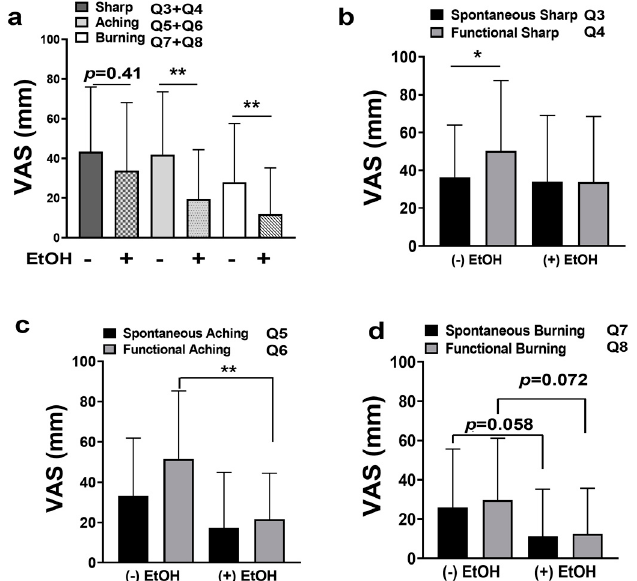
Figure 4. ( a ) VAS scores for total sharp pain (Q3 and Q4 combined), total aching pain (Q5 and Q6 combined), and for total burning pain (Q7 and Q8 combined) (+/ − ) EtOH consumption. ( b ) VAS scores for spontaneous sharp pain (Q3) vs. functional sharp pain (Q4) (+/ − ) EtOH consumption. ( c ) VAS scores for spontaneous aching pain (Q5) vs. functional aching pain (Q6) (+/ − ) EtOH consumption. ( d ) VAS scores for spontaneous burning pain (Q7) vs. functional burning pain (Q8). * p < 0.05, and ** p < 0.01.